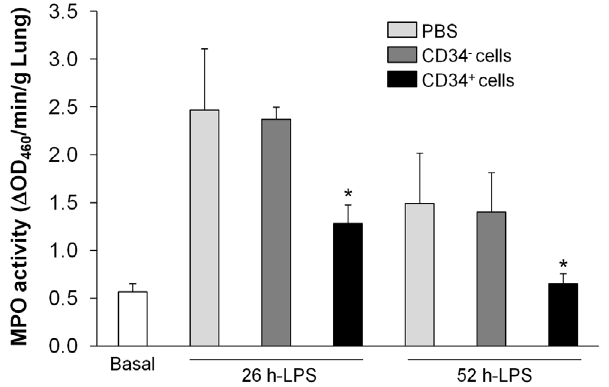
Figure 2. Inhibited lung inflammation in mice treated with fCB- CD34 + cells. Lung tissues at indicated times post-LPS challenge were collected for MPO activity determination. Data are expressed as mean 6 SD ( n =4/group). *, P , 0.05 versus PBS or CD34 2 .